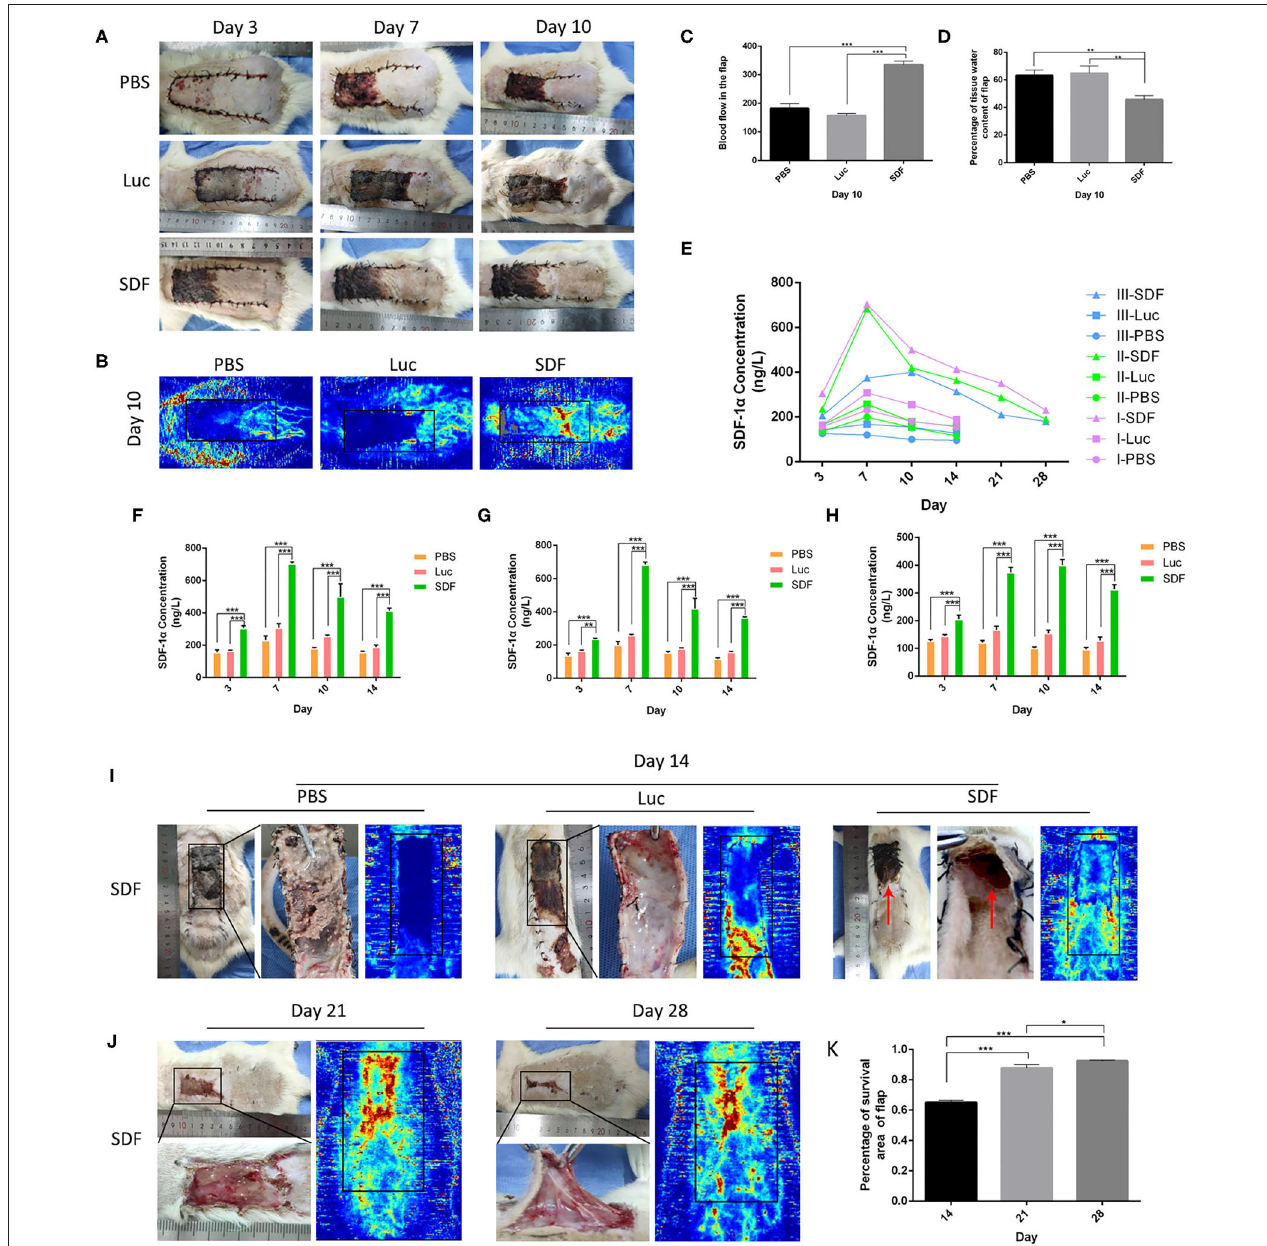
FIGURE 4 | Flap survival area and blood perfusion in the rat random skin flap model. (A,B) Representative images of skin flap models at each time-point and LDI. (C) Histogram of percentages of flap survival area and (D) tissue water content of skin flaps on post-operative day 10. (E) Time-course of SDF-1 α expression kinetics in random skin flaps post-transplantation, and are area of I, II, and III, respectively (F–H) . Representative images of skin flap models and LDI at day 14, 21, and 28 post-transplantation (I,J) . (K) Histogram of percentages of flap survival area. Data represent the mean ± SD ( n = 4). * P < 0.05, ** P = (0.01–0.05), *** P < 0.01.